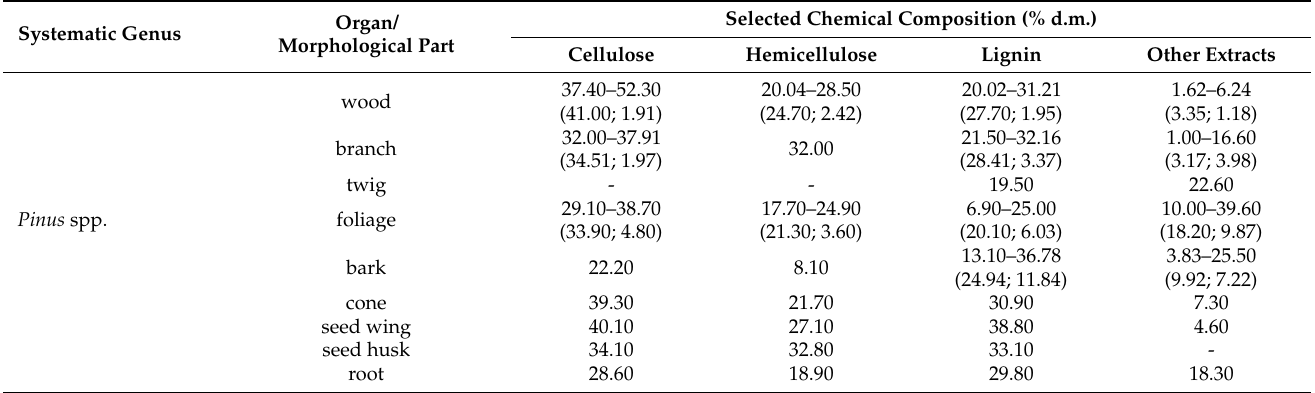
Table A3. Selected chemical composition of particular organs of various systematic genera of